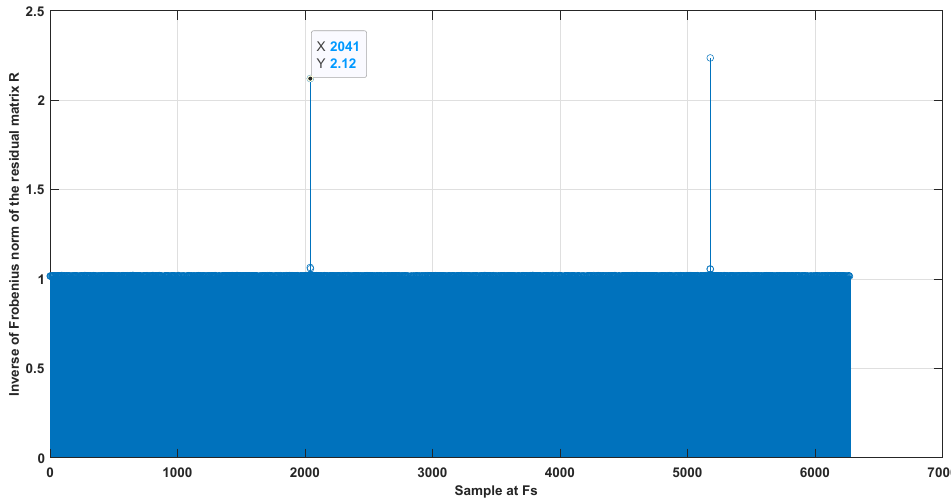
Figure 9. Coarse synchronization with identification of